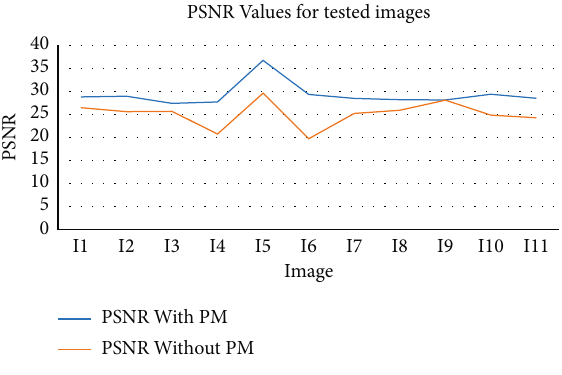
Figure 10: PSNR for tested images.